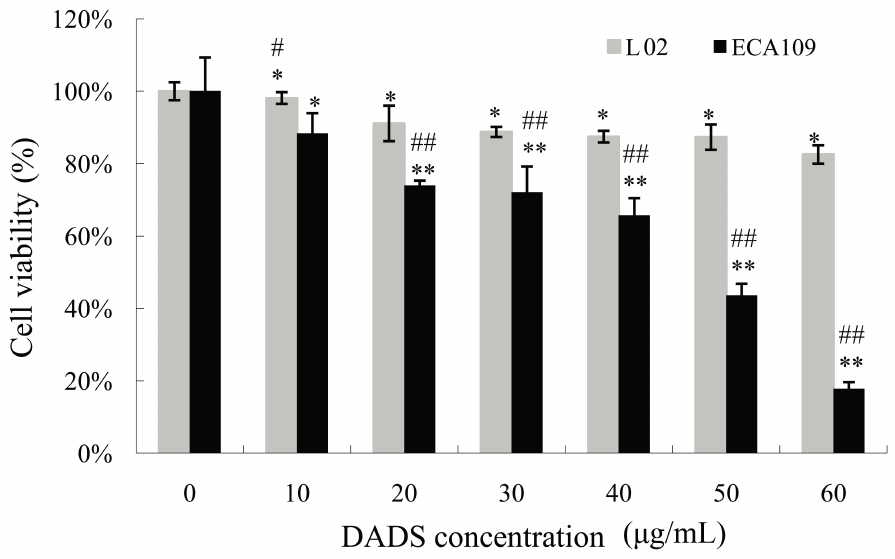
Figure 1. Viability inhibitory effects of diallyl disulfide (DADS) on ECA109 cells and L02 cells. ECA109 and L02 cells were incubated with different doses of DADS (0, 10, 20,